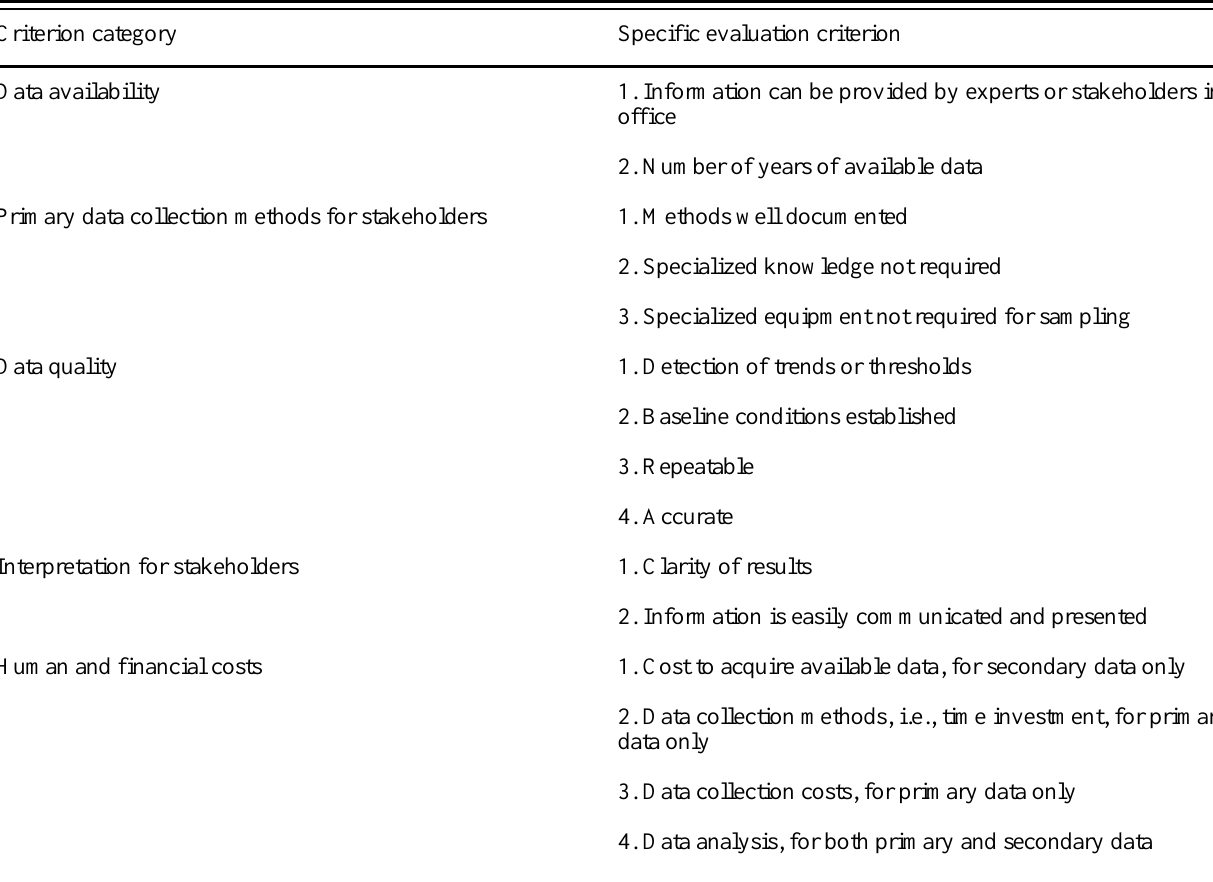
Table 3. Evaluation criteria to prioritize and weight the final list of indicators. Adapted from Tegler et al.